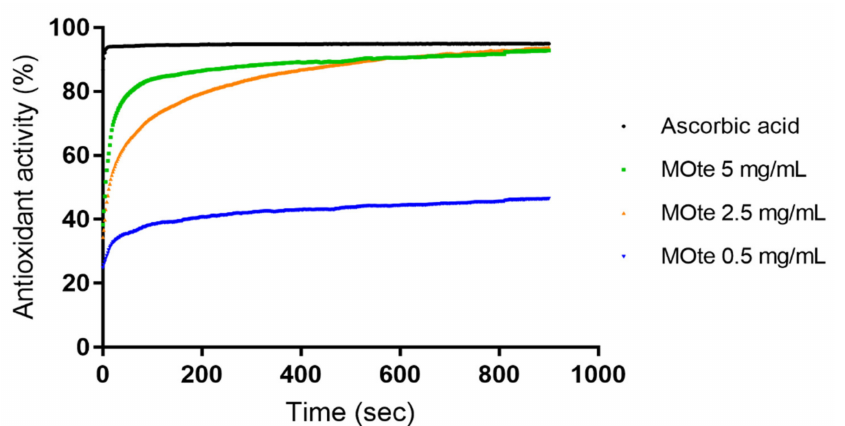
Figure 1. Time-dependent antioxidant activity of the Melissa officinalis leaves total